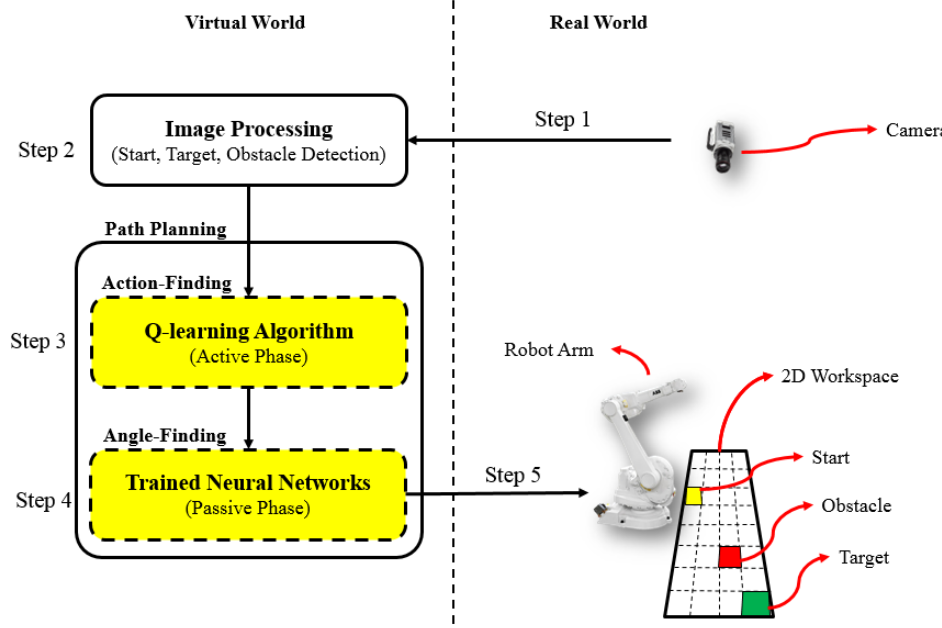
Figure 3. Method overview: 1. capturing picture, 2. image processing, 3. Q-learning, 4. neural network, 5. implementation.